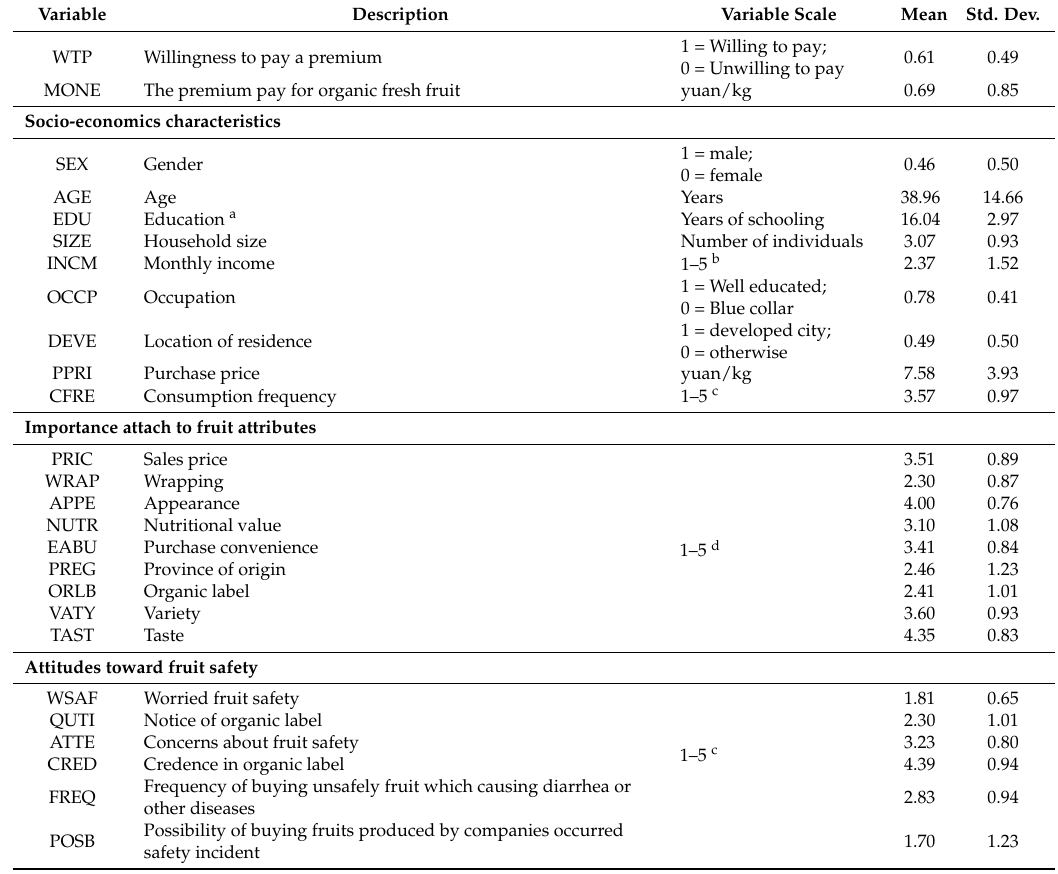
Table 1. Summary statistics for empirical